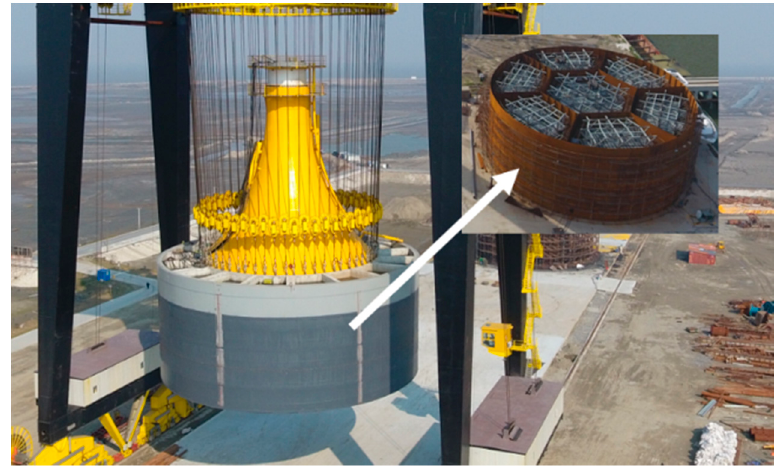
Figure 1. The composite bucket foundation (CBF).